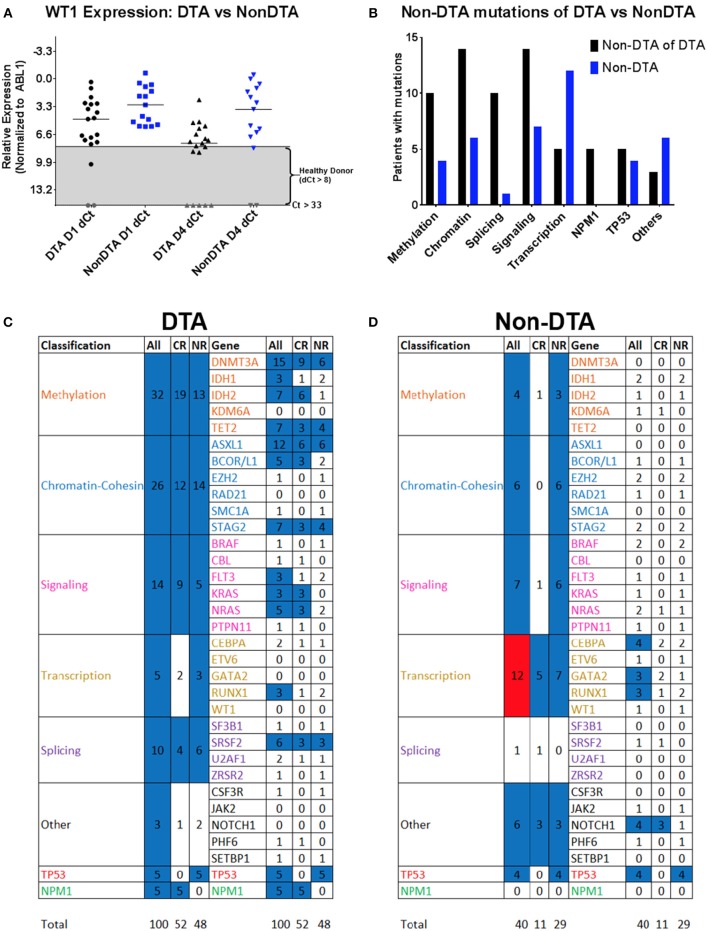
WT1 expression and gene variants in DTA and non-DTA patients. Patients were separated into groups based on detection of at least one DTA (DNMT3A, TET2, and ASXL1) mutation. The 34 genes in which variants were identified were classified into eight functional groups and Day 1 vs. 4 VAFs were analyzed with the Wilcoxon signed rank test. 162 coding variants were condensed into 140 by averaging the VAFs of multiple variants in the same gene in the same patient. The DTA group had 100 variants and the non-DTA group had 40 variants. (A) WT1 expression was higher in non-DTA patients compared to DTA patients. Out of the 34 patients with complete WT1 expression data, 19 patients were DTA patients and 15 were non-DTA. Here, non-DTA patients had higher relative WT1 expression than DTA patients at both D1 (median relative expression 3.07 compared to 4.75, P < 0.05) and D4 (median relative expression 3.59 compared to 7.60, P < 0.05). (B) Variants observed in DTA vs. non-DTA patients. NPM1 mutations were detected in DTA patients only and more DTA patients have variants in all functional gene groups compared to non-DTA patients except for transcription genes. (C,D) Heatmap of statistical significance between D1 vs. D4 VAFs of mutated genes in functional groups for both DTA and non-DTA patients. The “All Transcription” group in non-DTA patients was significant (P < 0.05, red) and NPM1, detected only in CR DTA patients, was marginally significant (blue, P = 0.0625). The remaining functional groups and individual genes were either nonsignificant (blue) or had too few data points to be analyzed (white). DTA, mutations in DNMT3A, TET2, or ASXL1; qPCR, quantitative real-time PCR; NGS: Targeted DNA sequencing. Gray, undetectable; Gray box indicates healthy donor range; VAF, variant allele frequency; CR, complete remission; NR, non-responder; DX, Day X.